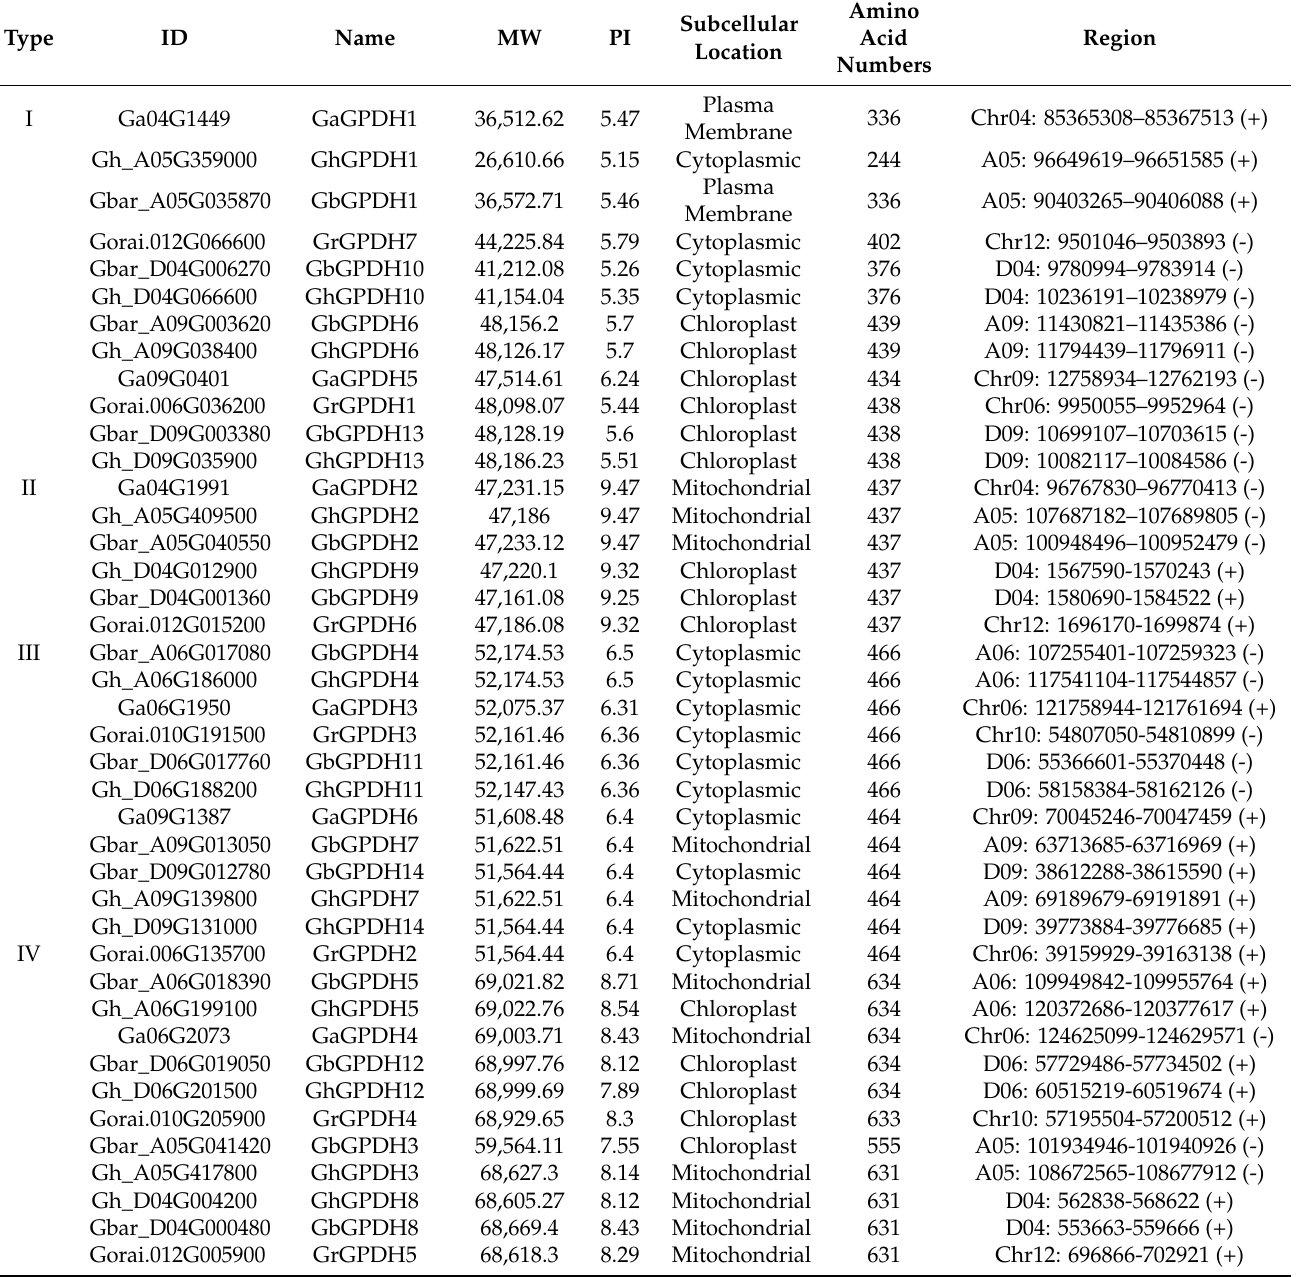
Table 1. Basic information of GPDH family genes in